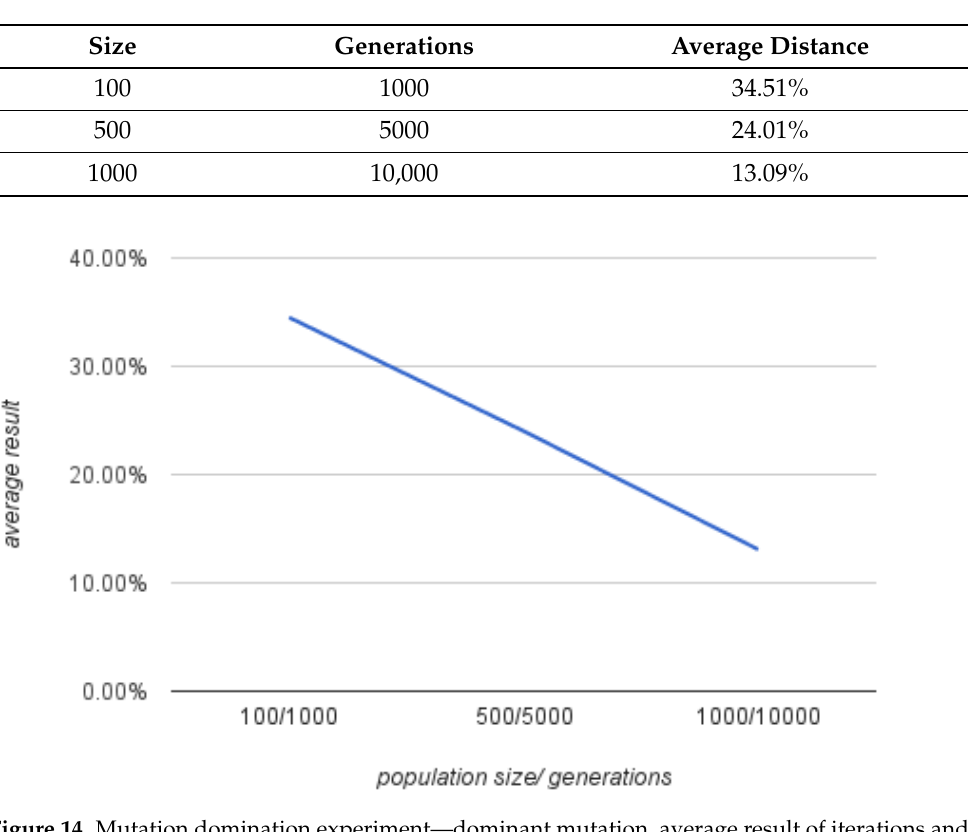
Figure 14. Mutation domination experiment—dominant mutation, average result of iterations and population